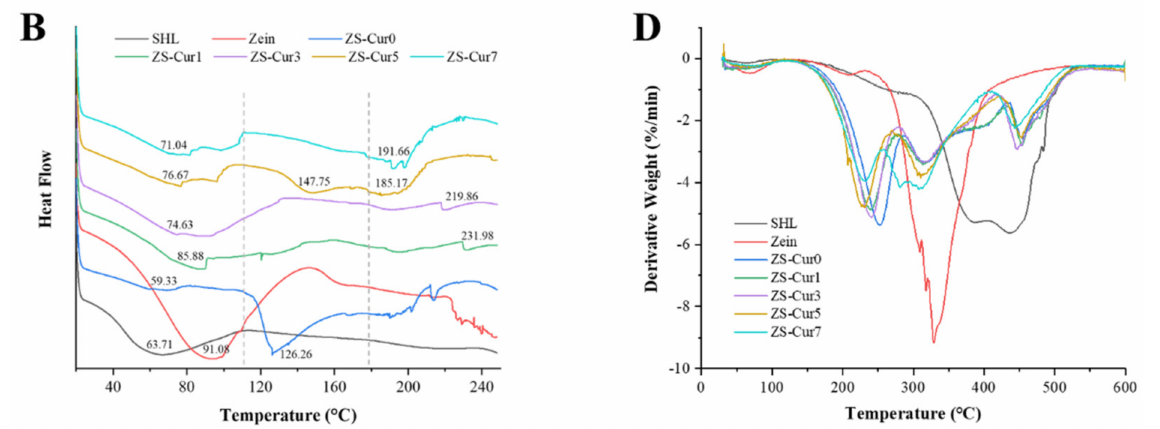
Figure 4. ( A ) XRD patterns, ( B ) DSC curves, ( C ) TGA, and ( D ) DTG curves of zein/shellac films loaded with